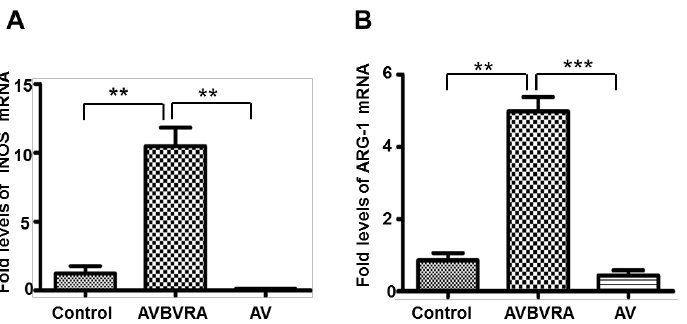
Figure 5. BVRA over-expressed macrophages showed increased INOS and ARG-1 expression levels. INOS ( A ) and ARG-1 ( B ) mRNA expression were detected by qRT-PCR in over-expressed BVRA macrophages; n = 4, *** p < 0.001, ** p < 0.01. Control: Macrophages with no virus; AVBVRA: Macrophages transfected with AV-BVRA; AV: Macrophages transfected with AV-negative